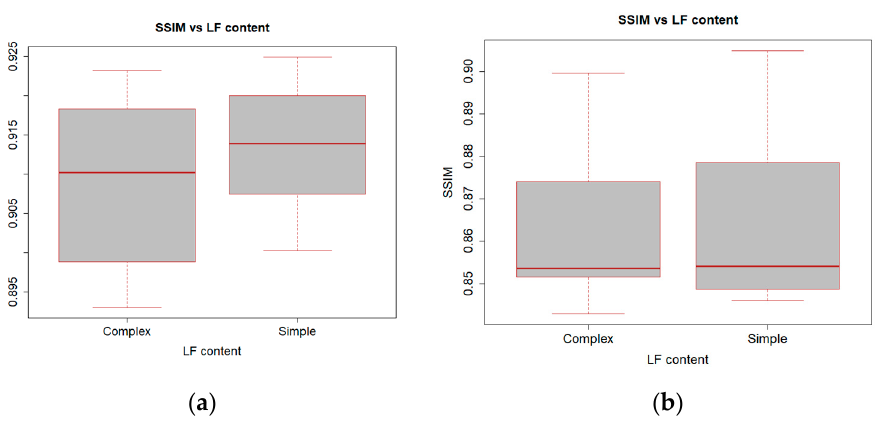
Figure 7. The variation of SSIM and LF contents with different distortion levels: ( a ) good quality case (QP22), ( b ) poor quality case (QP50).